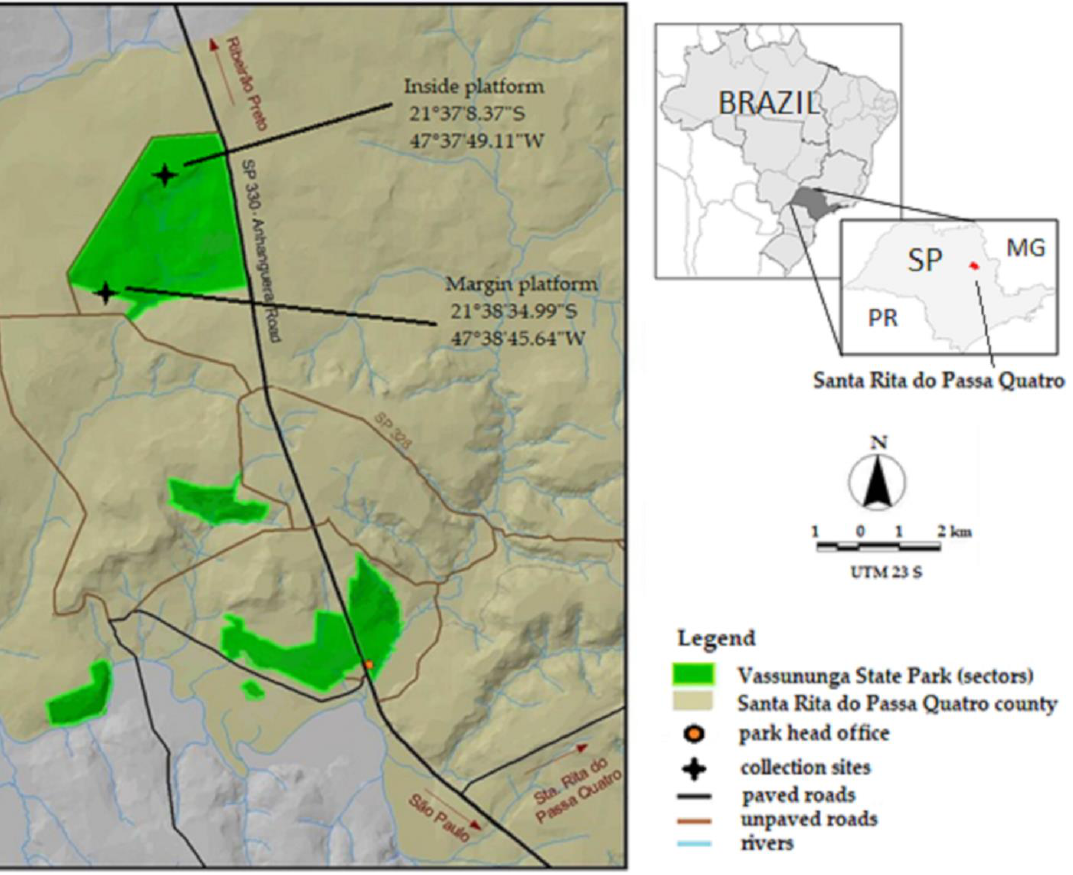
Figure 1. Location of the study area in the savanna biome, Vassununga State Park. Source: Plano de Manejo PEV, 2009.